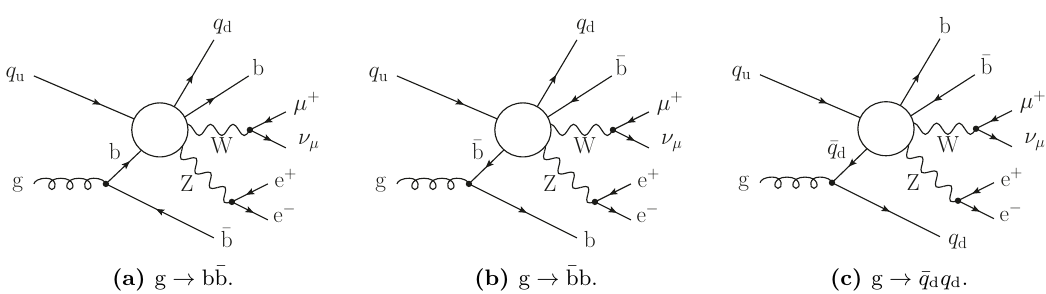
Figure 3. Real-radiation topologies embedding different initial-state collinear splittings in the g q u channel at O ( α 6 ) s α